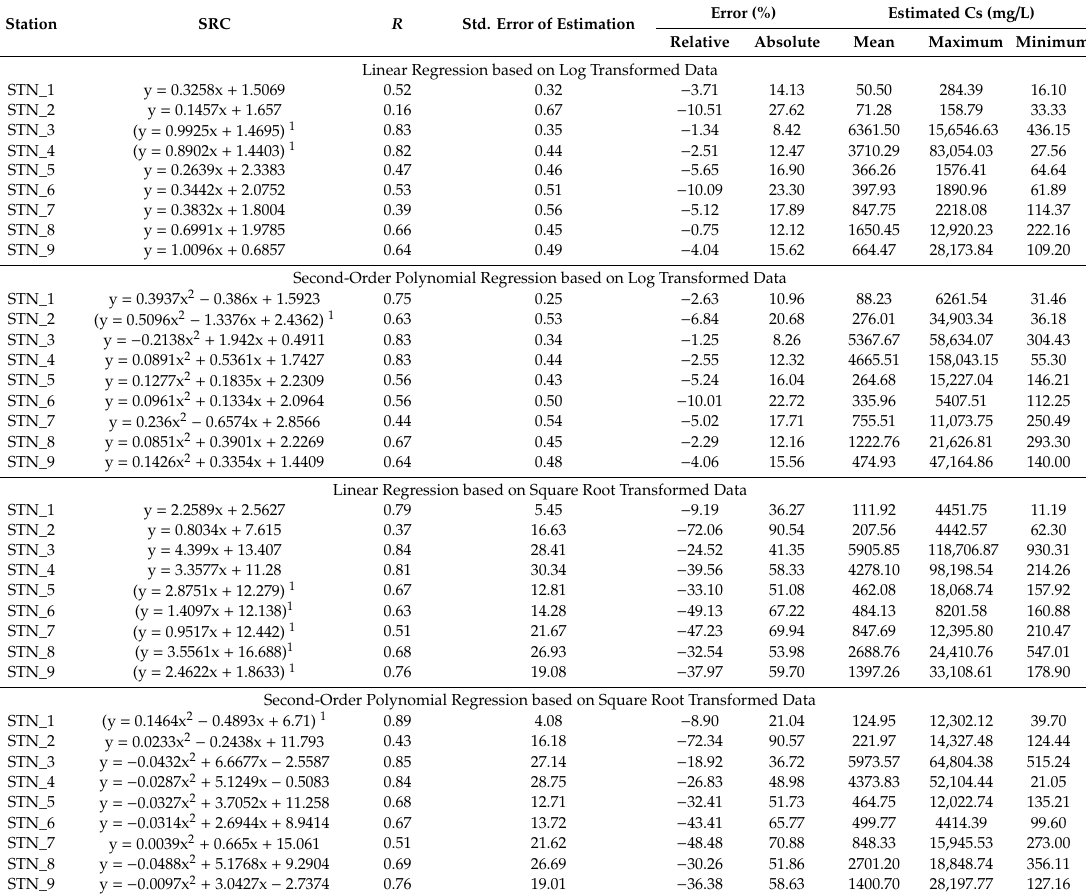
Table 6. Details and performance evaluation of sediment rating curve based on log transformation and square root transformation of the data in nine di ff erent